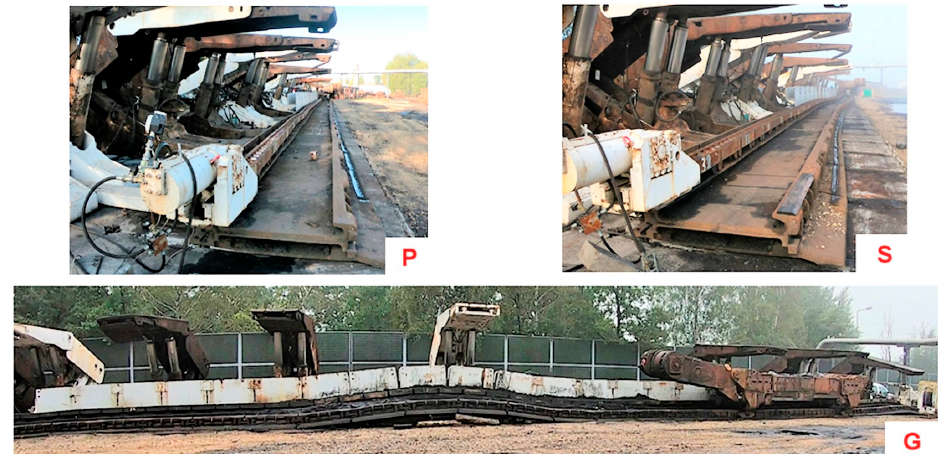
Figure 10. Three alternatives of situating the trough of the armored face conveyor simulating the conditions of underground operation: P—straight route of the conveyor, S—the route of the conveyor deflected in the horizontal plane by 800 mm, G—the route of the conveyor deflected in the vertical plane by about 300 mm.